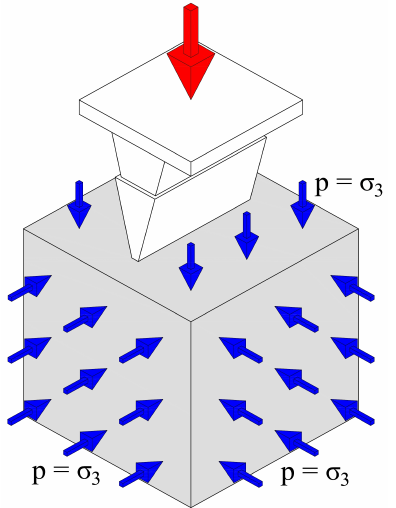
Figure 10. The position of the wedge in the modified wedge test method.